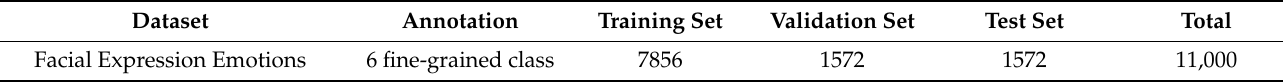
Table 2. List of associated characteristics for Facial Expression